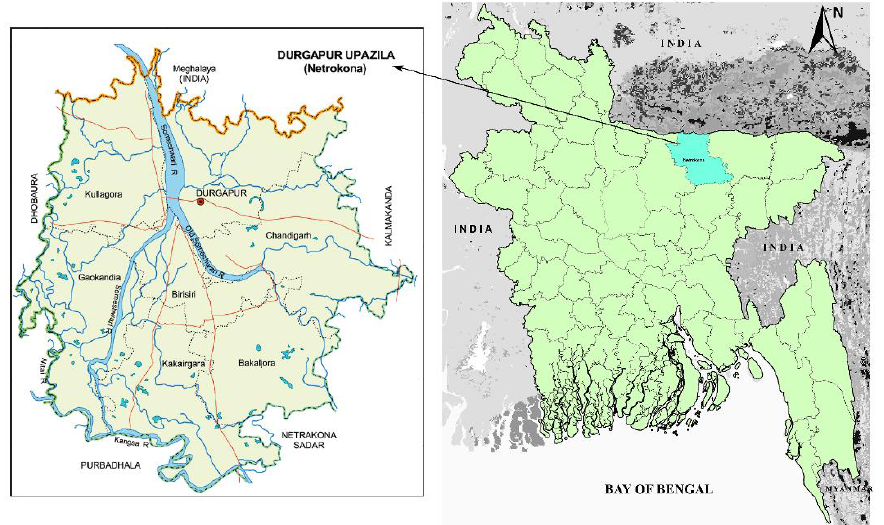
Figure 1. Map of study areas (GIS